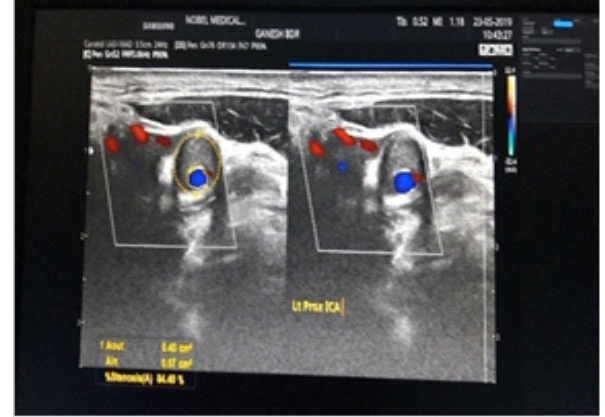
Figure 10: Signicant stenosis at proximal